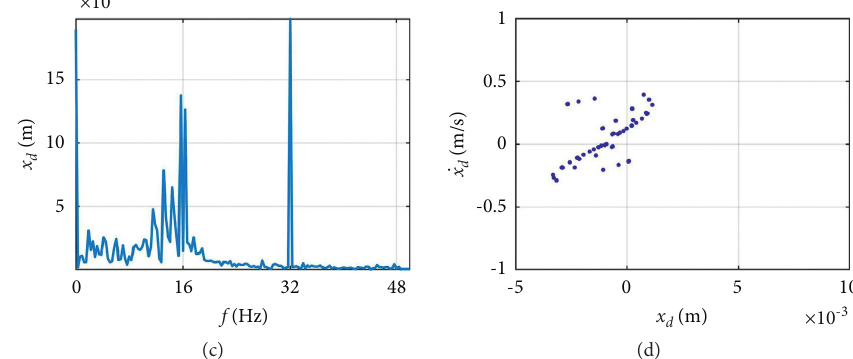
� 85 ) MN/m: (a) time history, (b) phase diagram, (c) frequency spectrum, and (d) s